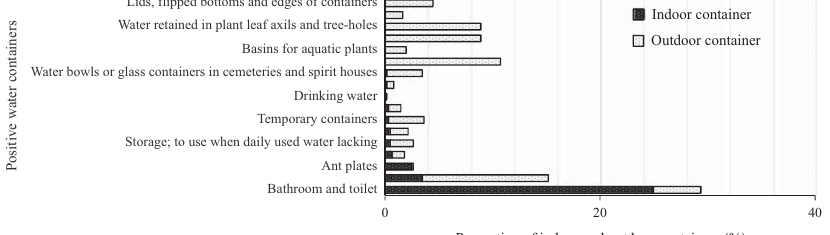
Figure 2. Proportion of indoor and outdoor